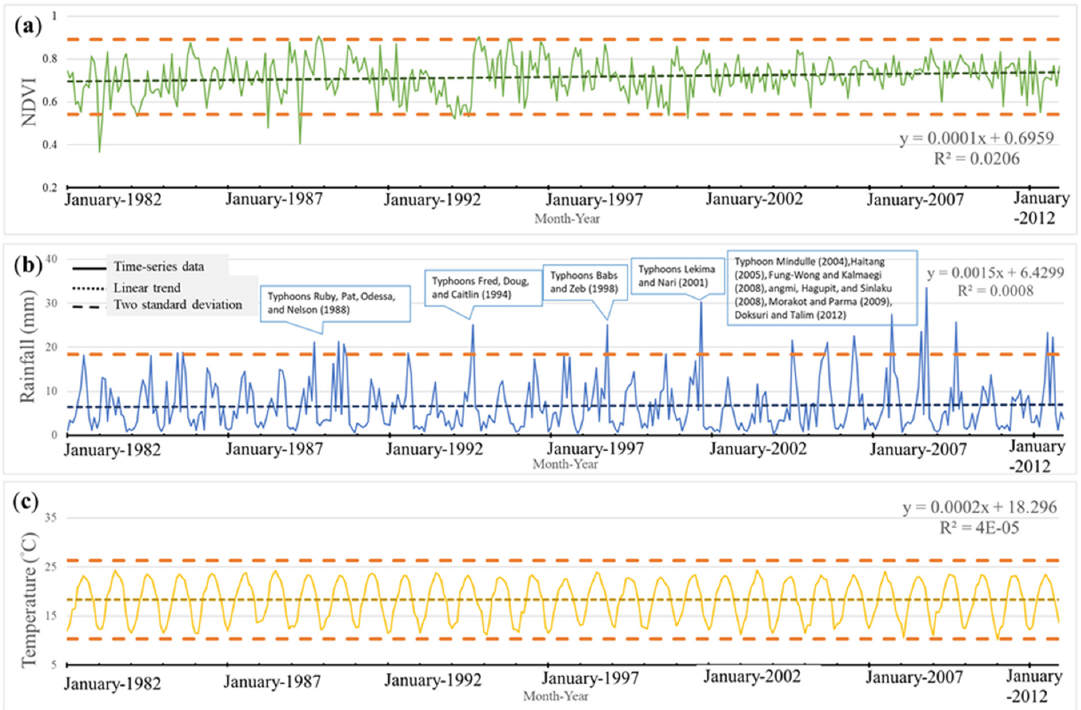
Figure A2. Average time series data of ( a ) NDVI, ( b ) rainfall, and ( c ) temperature extracted from selected 70 watersheds. The solid line represents the time series, the dotted line represents the linear trend, and the dashed line represents the two standard deviation bounds.